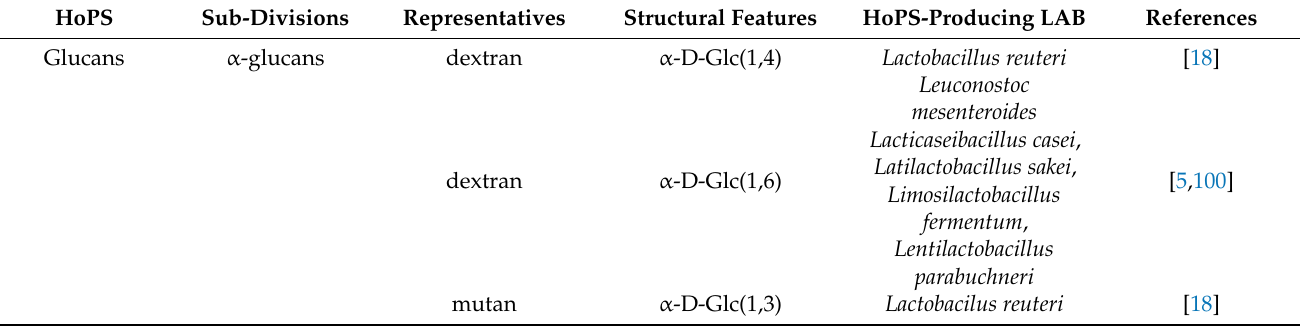
Table 2. Homopolysaccarides and corresponding LAB